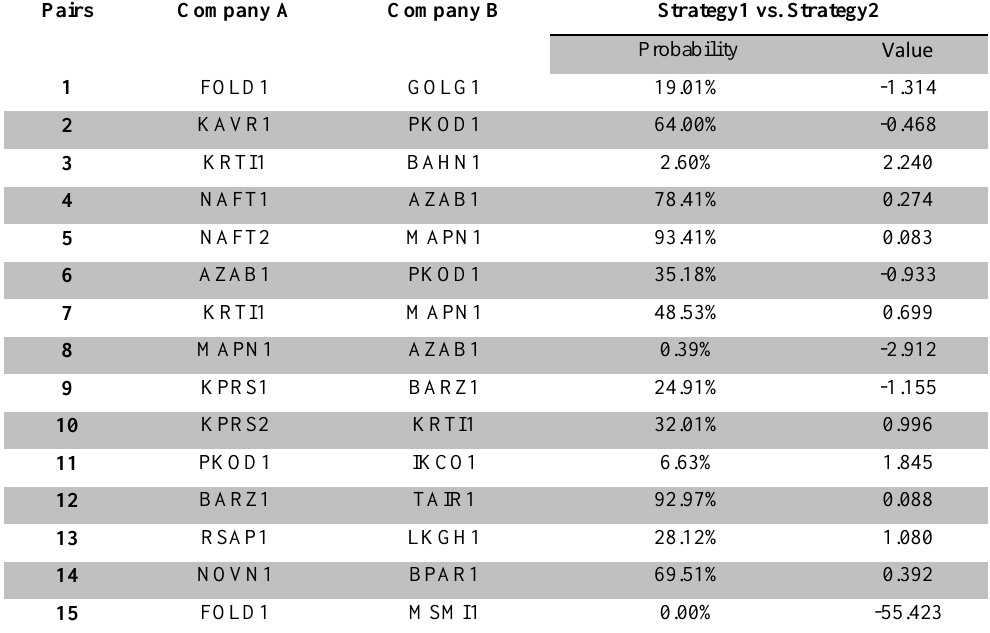
Results of the paired difference